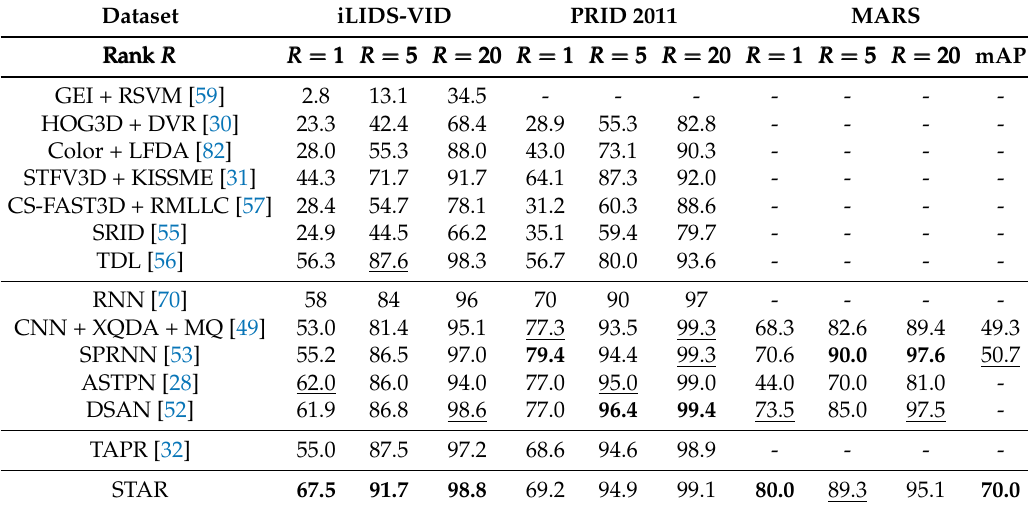
Table 1. Quantitative comparison of the proposed method and the state of the art methods on iLIDS-VID, PRID 2011 and MARS datasets. Bold and underlined values indicate the best and the second-best performance